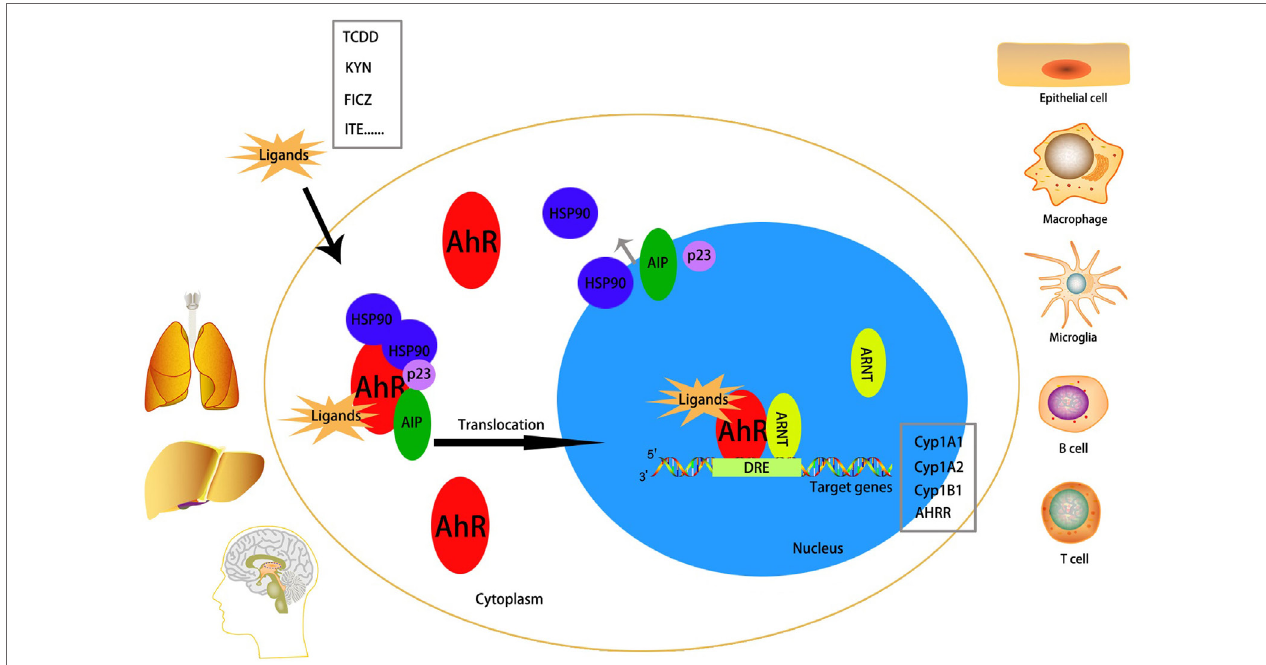
FigURe 2 | Mechanism of activation of the aryl hydrocarbon receptor (AhR). The AhR is abundantly expressed in lung, liver, and brain. It can be activated in many cell types, including epithelial cell, microglia, macrophage, B cell, T cell, etc. Without a ligand, AhR is inactivated in the cytoplasm as a part of a complex with heat shock protein (HSP)90, AhR-interacting protein (AIP), and p23. After binding with an exo/endogenous ligand, the AhR will be activated and translocates to the nucleus to interact with AhR nuclear translocator (ARNT) and simultaneously detaches from the complex. The AhR/ARNT heterodimer finally binds to the dioxin- response elements (DREs), which is called the promoter region of target genes [classical target genes include cytochrome P450 (Cyp)1a1, Cyp1a2, Cyp1b1, and AHRR], to promote transcriptional